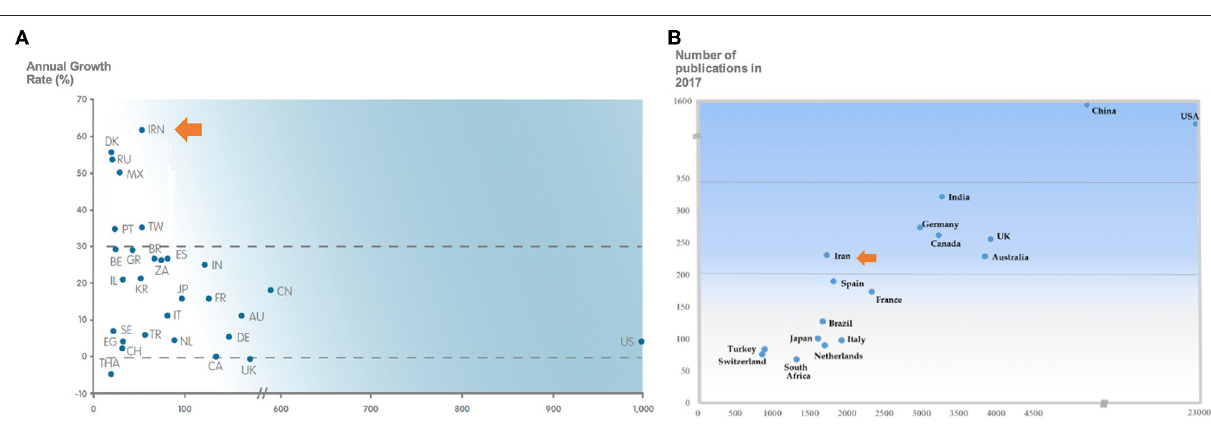
FIGURE 3 | (A) Annual percentage growth per average annual article output [Source: Scopus, adapted from SciVal (2011)]; (B) Top 16 countries in accordance to their publications in water research in 2017, and total publication output (1910–2017) “water resource”, 2005–2008 (Source: